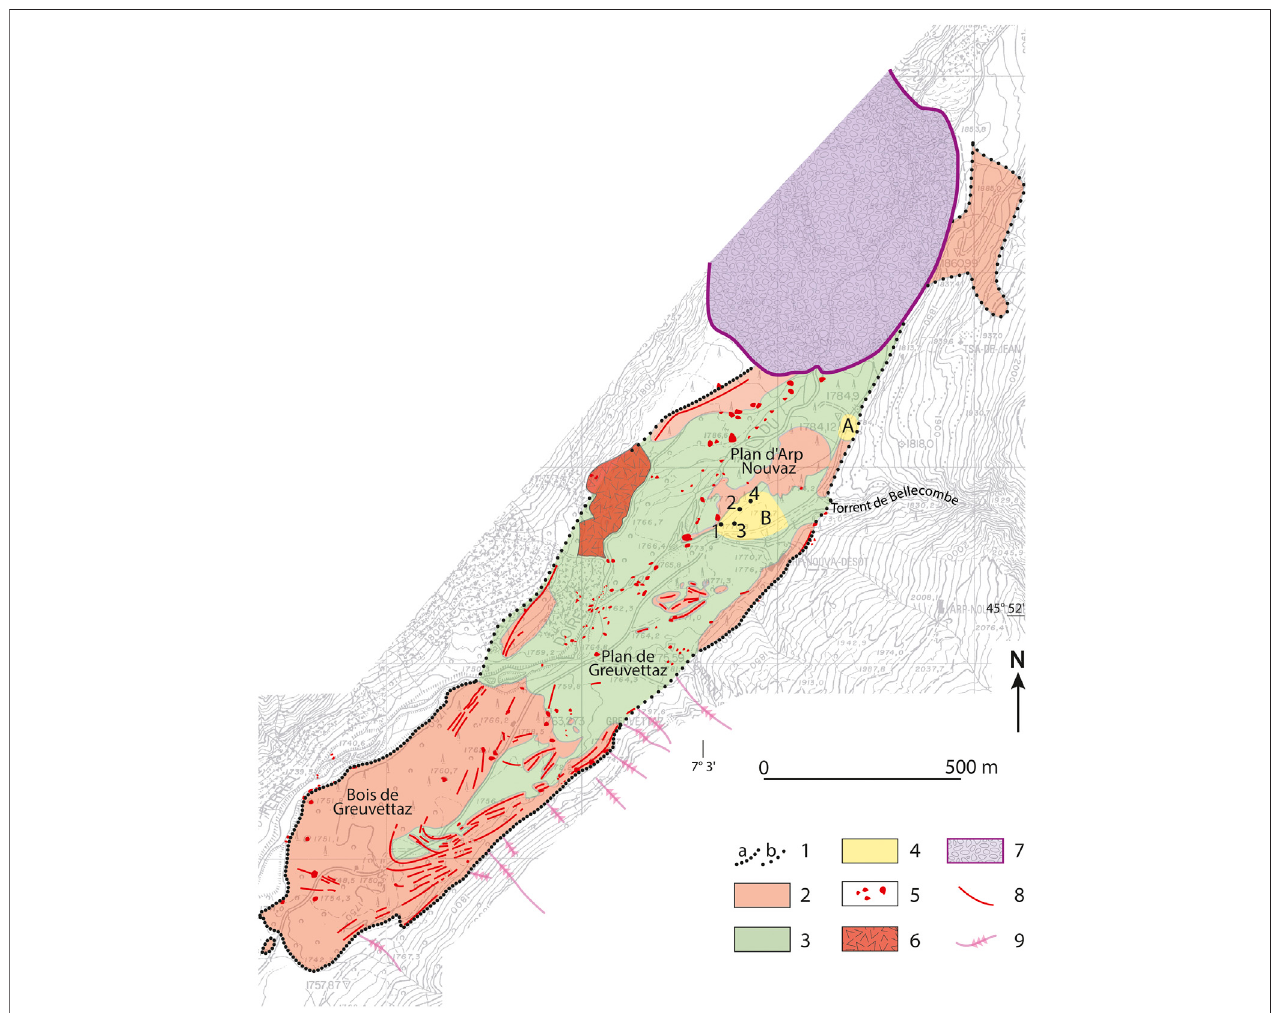
FIGURE 2 | Geomorphological map of the rock avalanche deposit of 1717 CE. 1: Limit of the deposit [ (A) : recognized; (B) : inferred]; 2: chaotic block deposit; 3: alluvial deposit; 4: peat bog; 5: megablocks; 6: local rockfall deposit; 7: Holocene moraine complex of Triolet Glacier; 8: granitic ridges; 9: snow avalanche couloir; (A) : peat bog sampled by Aeschlimann (1983), (B) : peat bog sampled by Orombelli and Porter (1988), and Deline and Kirkbride (2009); 1 – 4: location of pits from this study (Topographic map: 1:10,000 with 10 m contour interval. Archivi topocartogra fi ci della Regione Autonomo Valle d ’ Aosta — permit no. 52 – 18/08/1999).